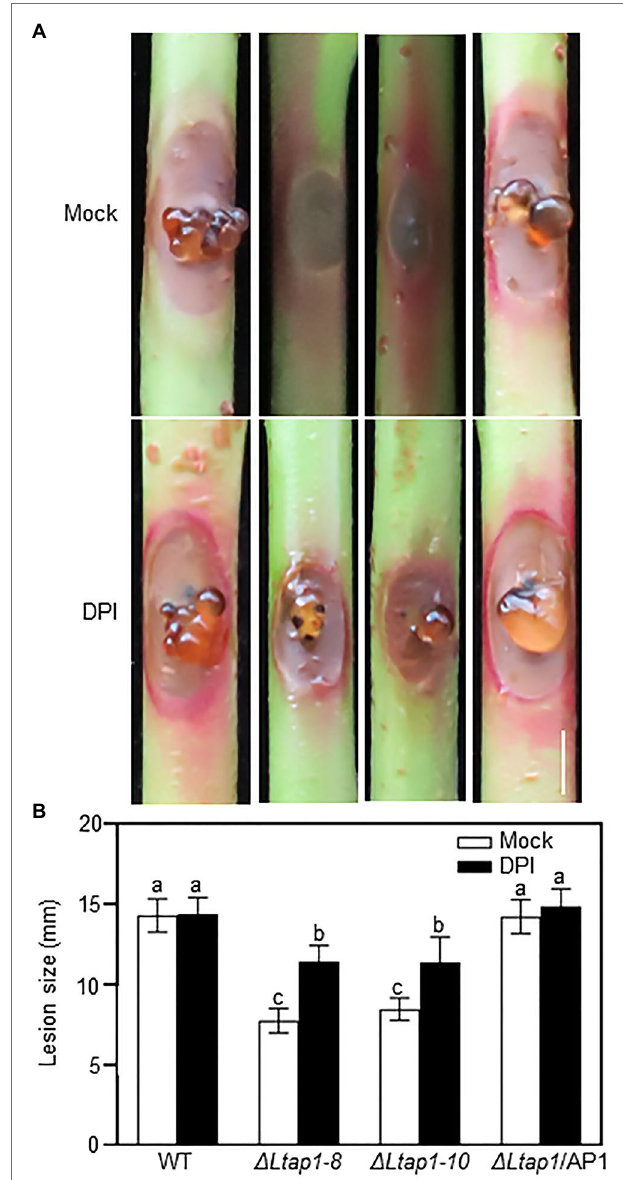
FIGURE 7 | Impact of diphenylene iodonium (DPI) on pathogenicity of LtAP1 mutants. (A) : Symptom of different genotypes of L. theobroame -inoculated peach shoots was treated with 0.4 μ m DPI [dissolved in dimethyl sulfoxide (DMSO) and then diluted with water; an NADPH oxidase inhibitor] or not (mock, 0.04% DMSO) at 5 dpi. Bar represents 5 mm. (B) Quantification of lesion size in infected shoots. All data are means ± SD of three biological replicates. Different letters indicate the significant difference at p <